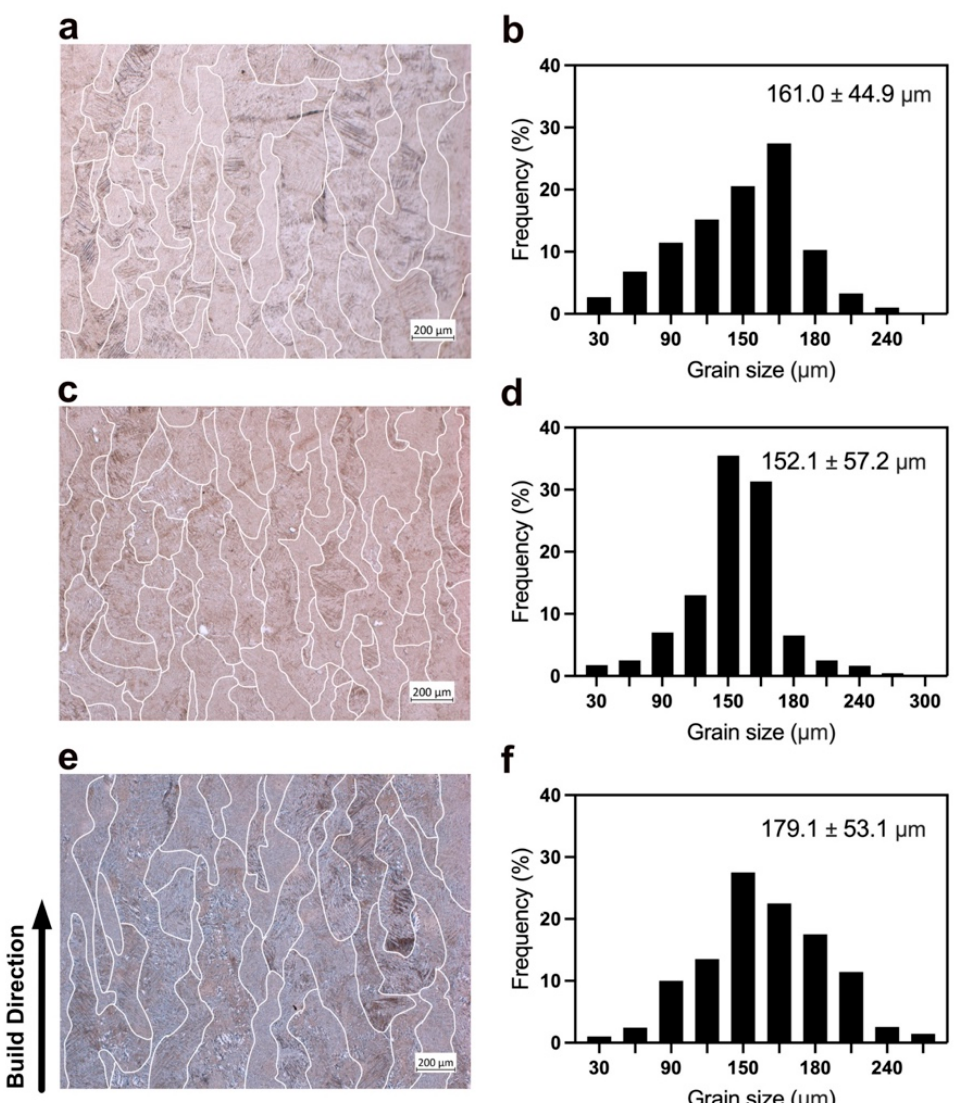
Figure 5. Representative optical microscopy images of ( a ) 850-WQ sample; ( c ) 850-AC sample; ( e ) 850-FC sample. The prior β grain boundaries in ( a , c , e ) are traced by white-color lines. The histograms of prior β -phase grains size are shown in ( b , d , f ).